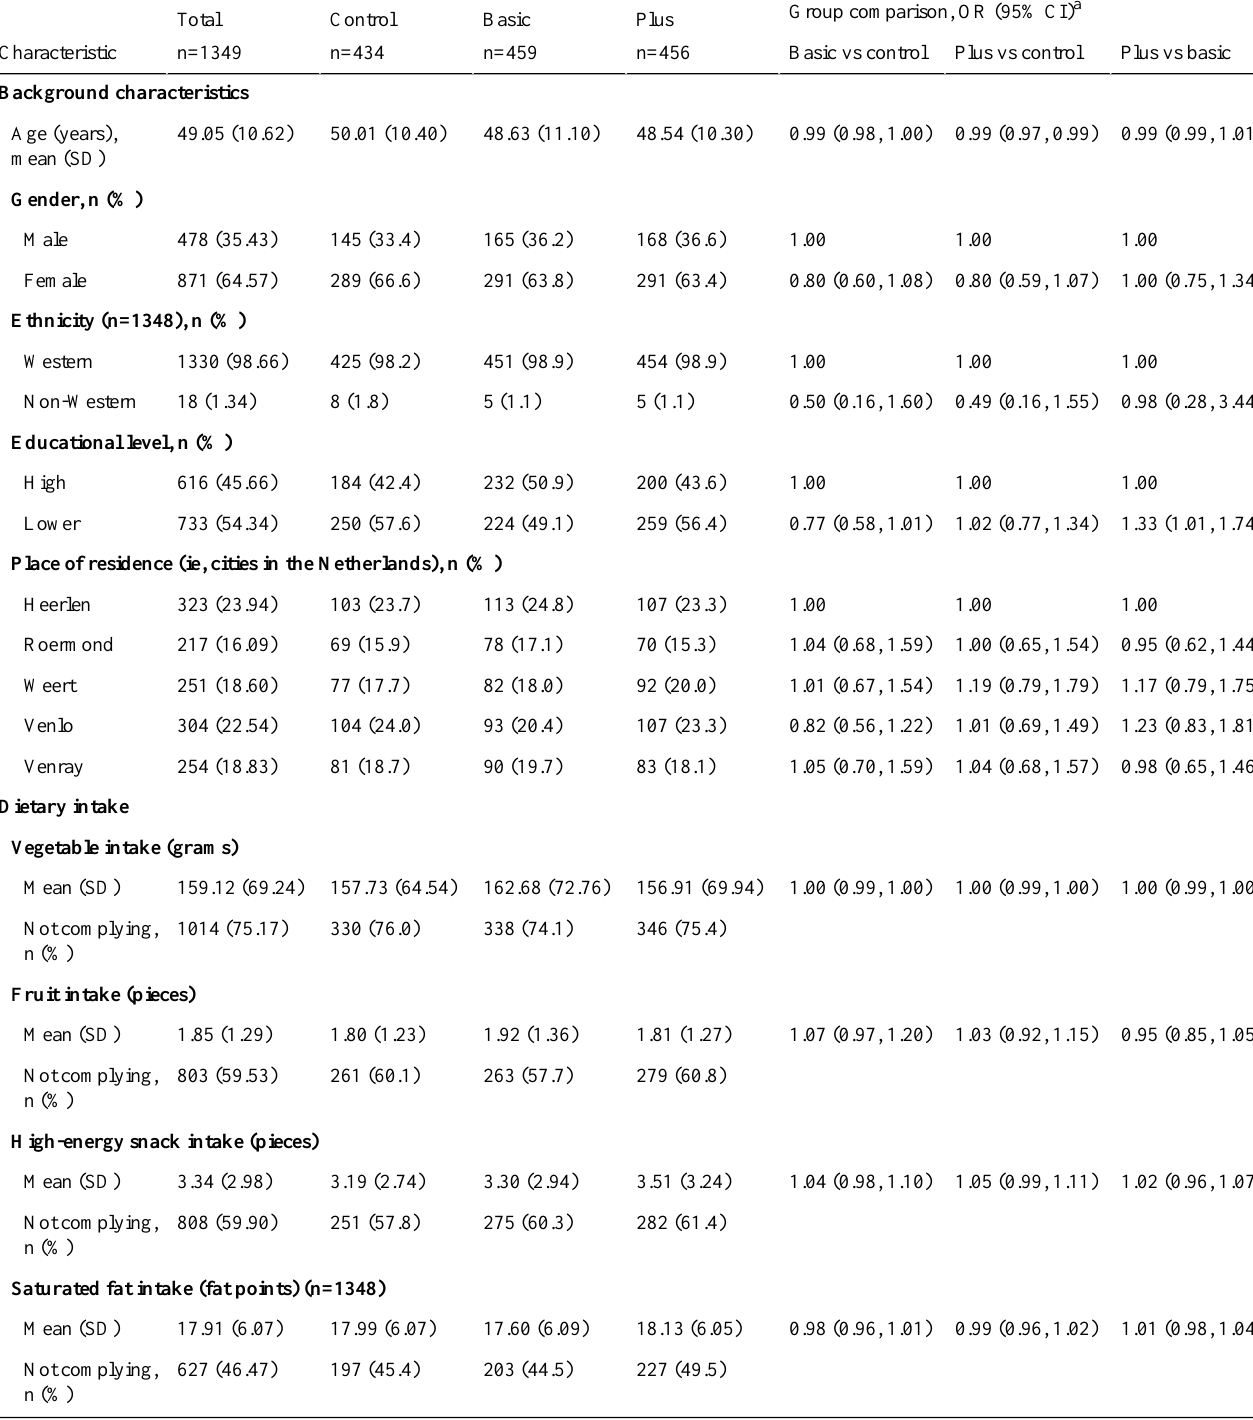
Table 1. Participant characteristics at